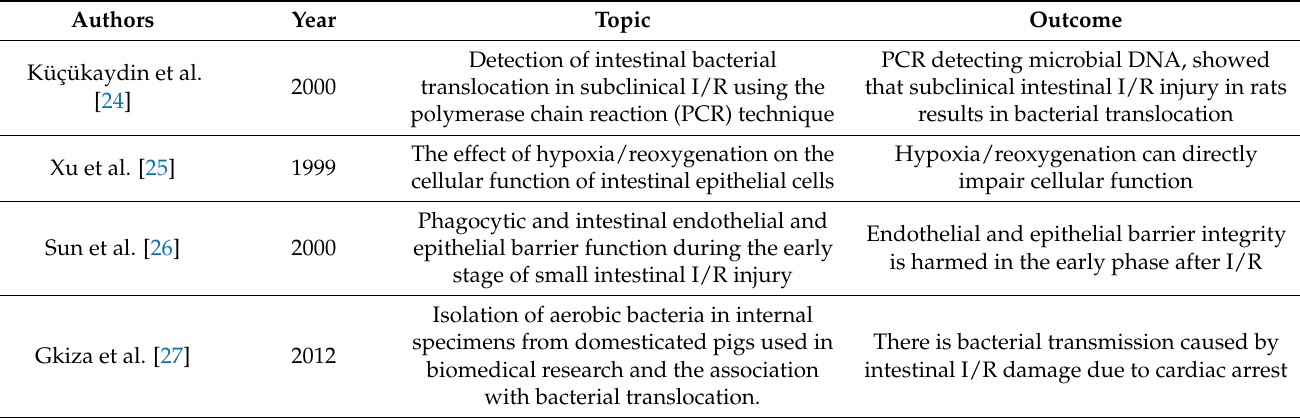
Table 3. The intestinal barrier function and I/R